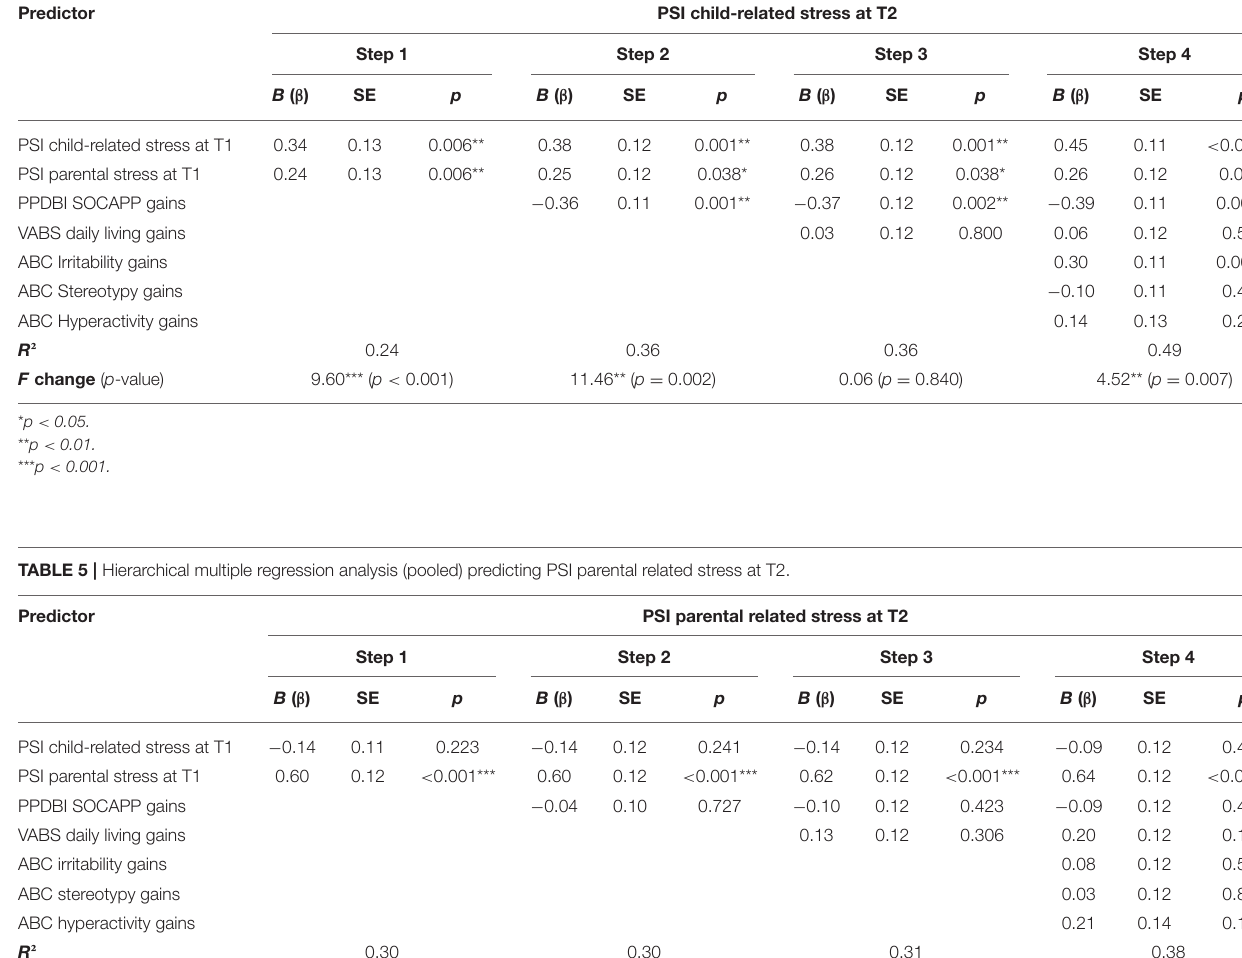
TABLE 4 | Hierarchical multiple regression analysis (pooled) predicting PSI child-related stress at T2. Predictor